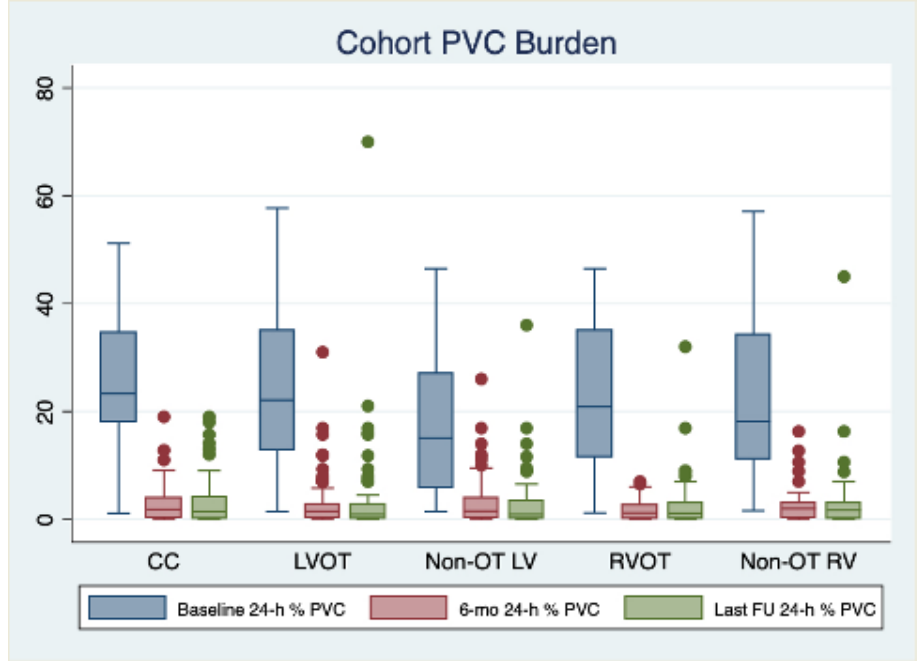
Figure 1. Changes in 24 h% burden over time stratified by PVC localization. Abbreviations: CC: coronary cusps, LV: left ventricle, LVOT: left ventricular outflow tract, OT: outflow tract, RV: right ventricle, RVOT: right ventricular outflow tract.